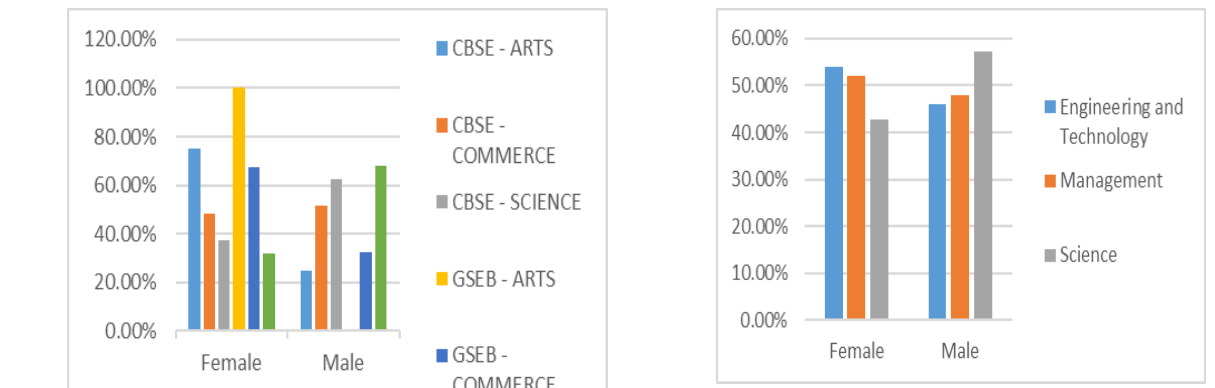
Figure 3. Distribution of data for school students’